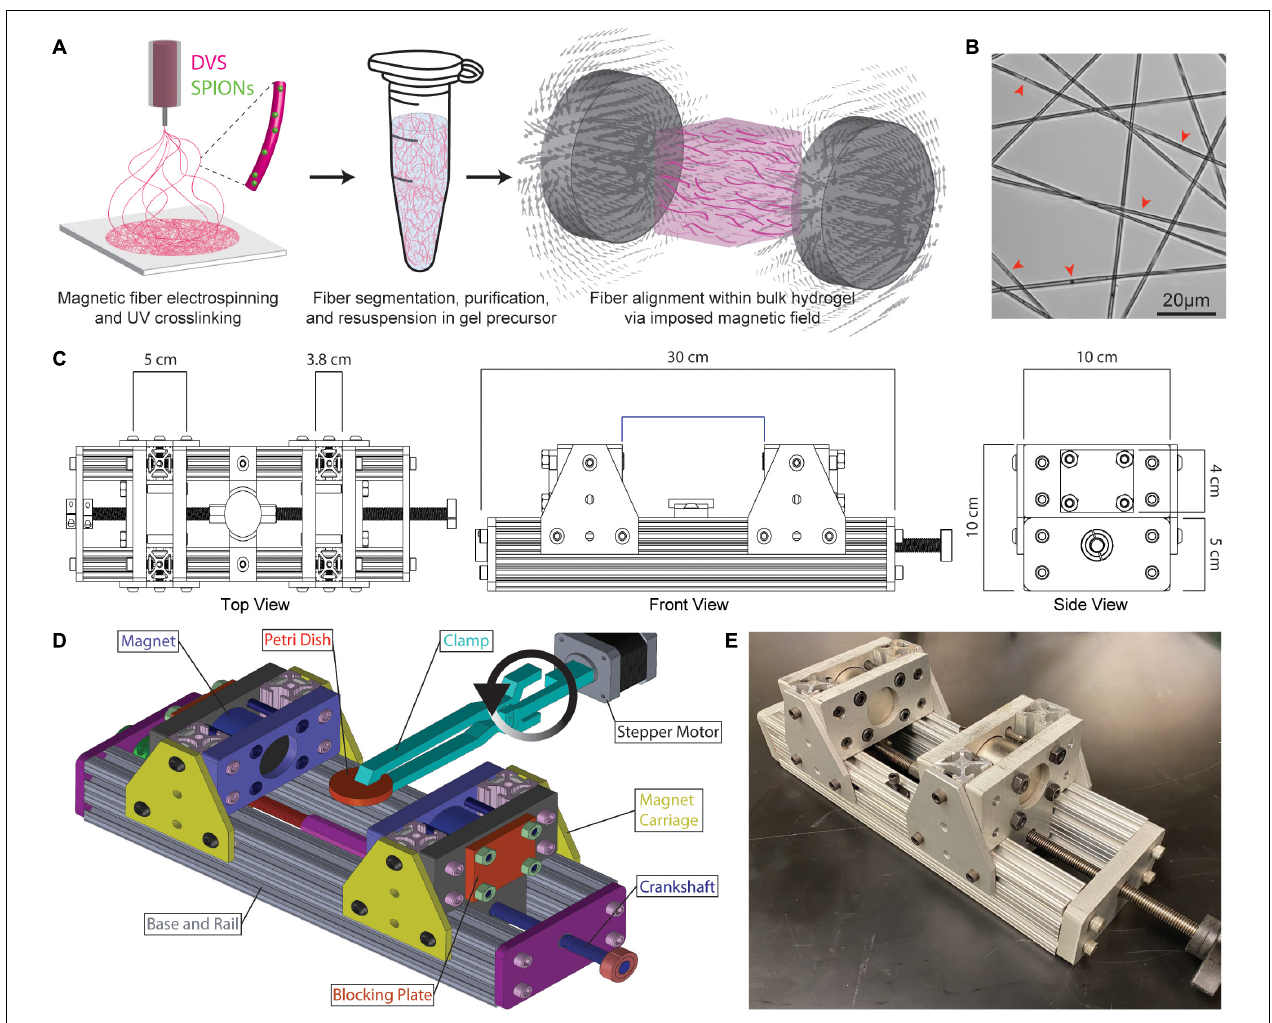
FIGURE 1 | Fabrication and magnetic alignment of SPION-containing electrospun DVS fiber segments. (A) Schematic overview of DVS polymer electrospinning, collected fiber suspension within a bulk hydrogel precursor solution, and alignment of SPION-containing fibers within an externally applied magnetic field. (B) Transmitted light image of SPIONs within electrospun DVS fibers. Red arrowheads indicate SPIONs. (C) Top, front, and side views of magnetic gelation chamber containing variably spaced neodymium magnets to control magnetic field strength during hydrogel gelation. (D) AutoCAD rendering of the magnetic gelation chamber with Arduino-controlled stepper motor to flip hydrogel composites during crosslinking and prevent fiber settling. (E) Photo of the final magnetic gelation